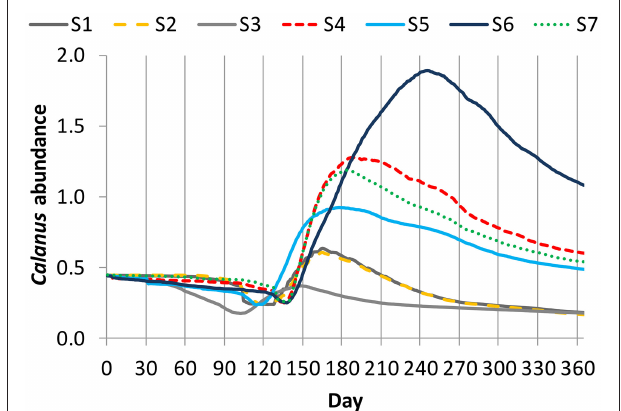
FIGURE 10 | The seasonal development in simulated copepod abundance in the 7 simulations (S1–7) for the year “1983” in the best replicate of each